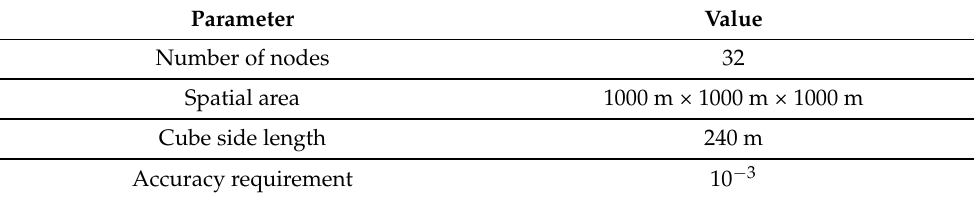
Table 2. Simulation parameters (cube shape).